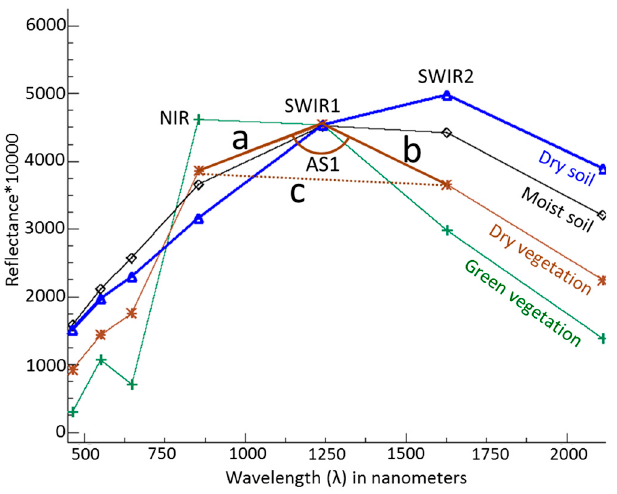
Figure 3. Computation of the SASI Index, adapted from Palacios-Orueta et al. [35]. Slope takes negative values in spectra with high water content such as green vegetation and positive values for dry soils; vegetation residues and dry vegetation hold a slope close to zero. The value of AS1 [44], is typically large (from 2 to 3.14 rad) for green vegetation and dry soils, and smaller (lower than 2 rad) for wet soils and dry vegetation. In line with this, the product of the angle and slope is large and positive for dry soils, and large and negative for green vegetation. For dry matter, SASI takes values close to zero, as both the angle and the slope are small. In wet soils, the index is positive but small due to a decrease in the value of AS1.